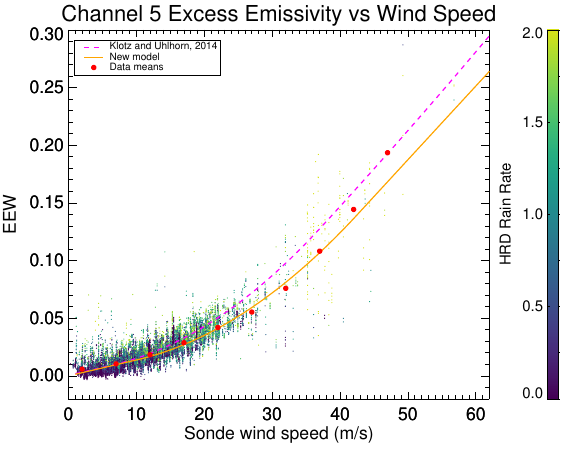
Figure 3. Uncorrected excess emissivity due to wind as a function of dropsonde wind speed. Colors on the small points indicate the associated HRD rain rate. Solid circles are means in 5 ◦ bins starting at 2ms − 1 . The dashed line is the operational GMF [8] and the solid line is the GMF derived from the data points above 10ms − 1 .